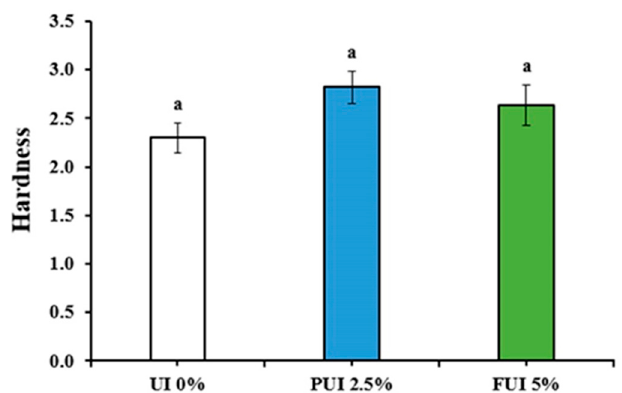
Figure 2. Hardness (kg/cm 2 ) comparison of cookies prepared with UI 0%, PUI 2.5%, and FUI 5% UI. Data represent the mean ± SE of 3 observations, where groups not sharing a letter are expressed as significantly different ( p < 0.05).